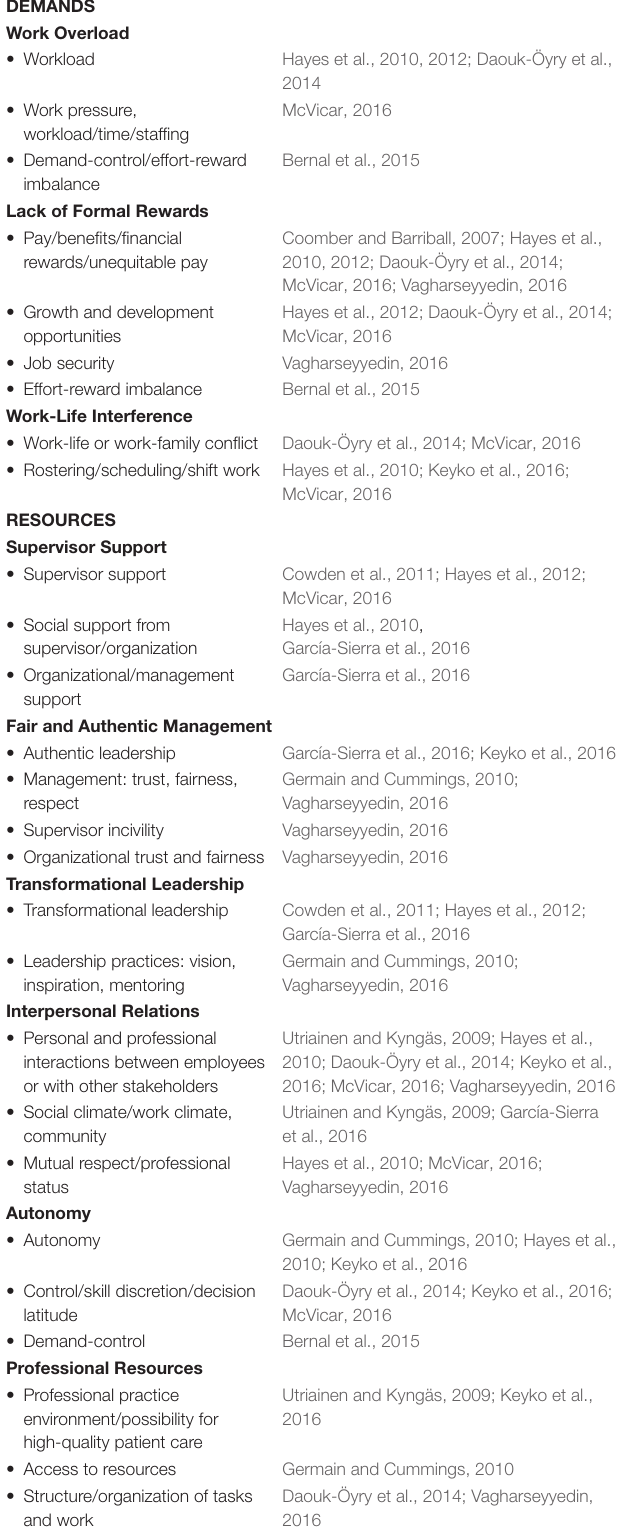
TABLE 3 | Identified key job demands and resources of nursing staff with represented